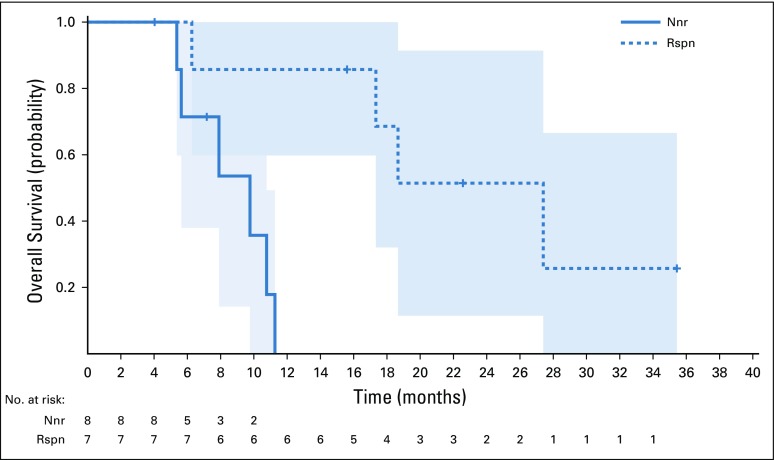
Overall survival: responders/nonresponders. Kaplan-Meier overall survival curves for non-responders (solid line) and responders (complete remission/complete remission with incomplete blood count recovery/partial response; dashed line) were assessed in 15 evaluable patients who received at least three cycles of treatment. Overall survival time was seen to be greater in those patients who responded to treatment (P = .004). Nnr, non-responders; Rspn, responders.